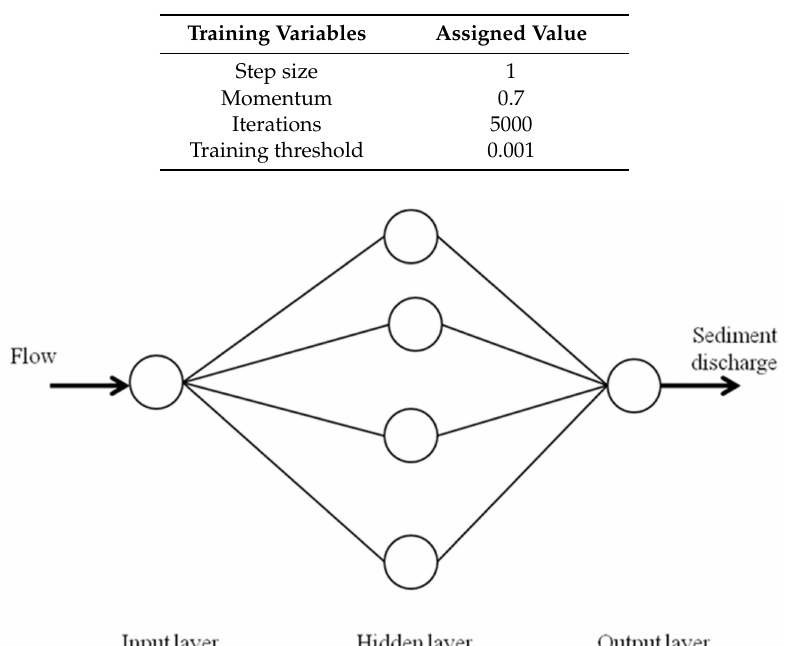
Table 2. Configurations of MLP during training.